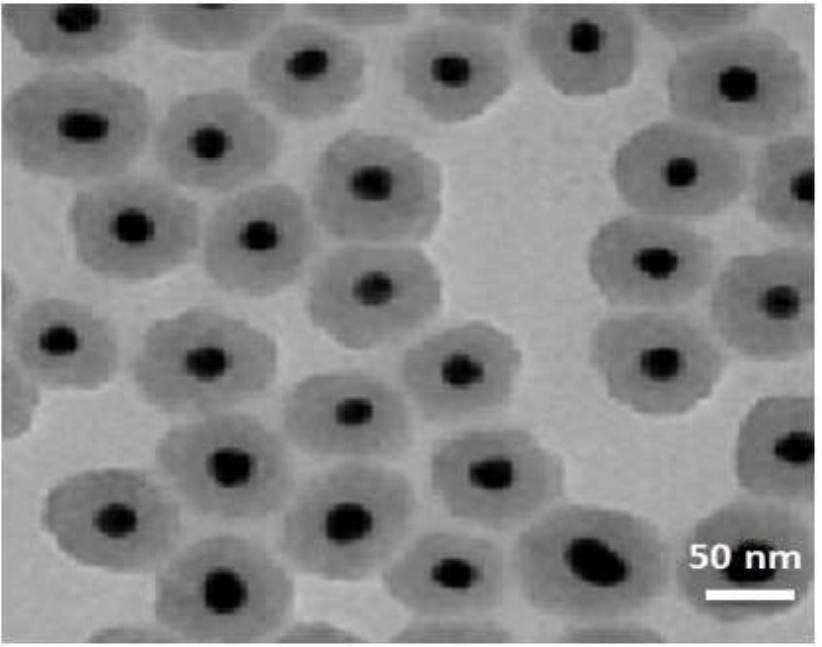
Figure 3. TEM micrographs of Fe@Au NPs at laser wavelength